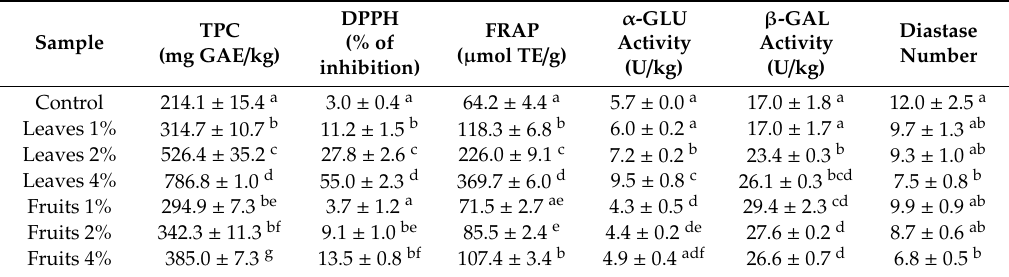
Table 5. Total phenolic compounds content (TPC), radical scavenging activity (DPPH test), reducing antioxidant powers (FRAP assay), and activity of α -glucosidase ( α -GLU) and β -galactosidase ( β -GAL), as well as diastase number, in tested enriched creamed honeys.